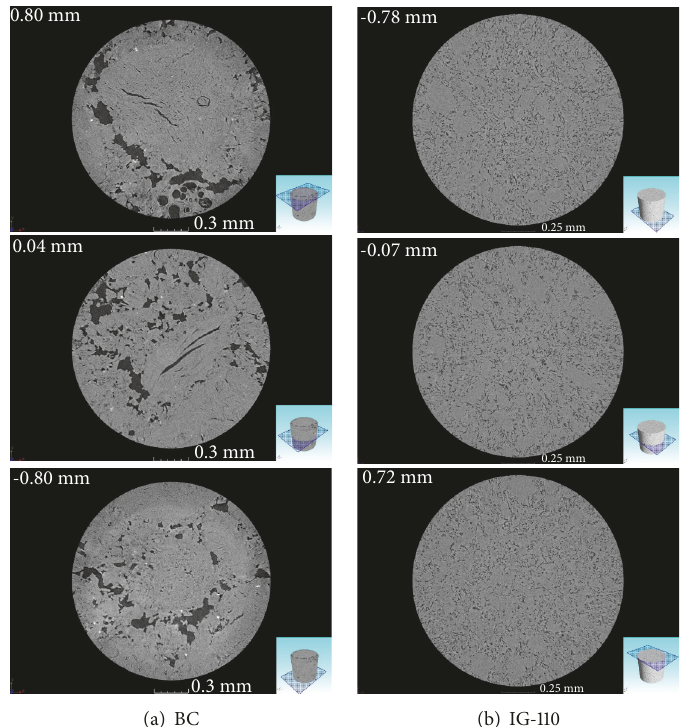
Figure 6: Slice images of different positions of BC and IG-110. Three slice pairs from 3D Micro-CT images of BC and IG-110 were identified along the core axis, and the position of the slice is shown in the three-dimensional model of the lower right corner in the